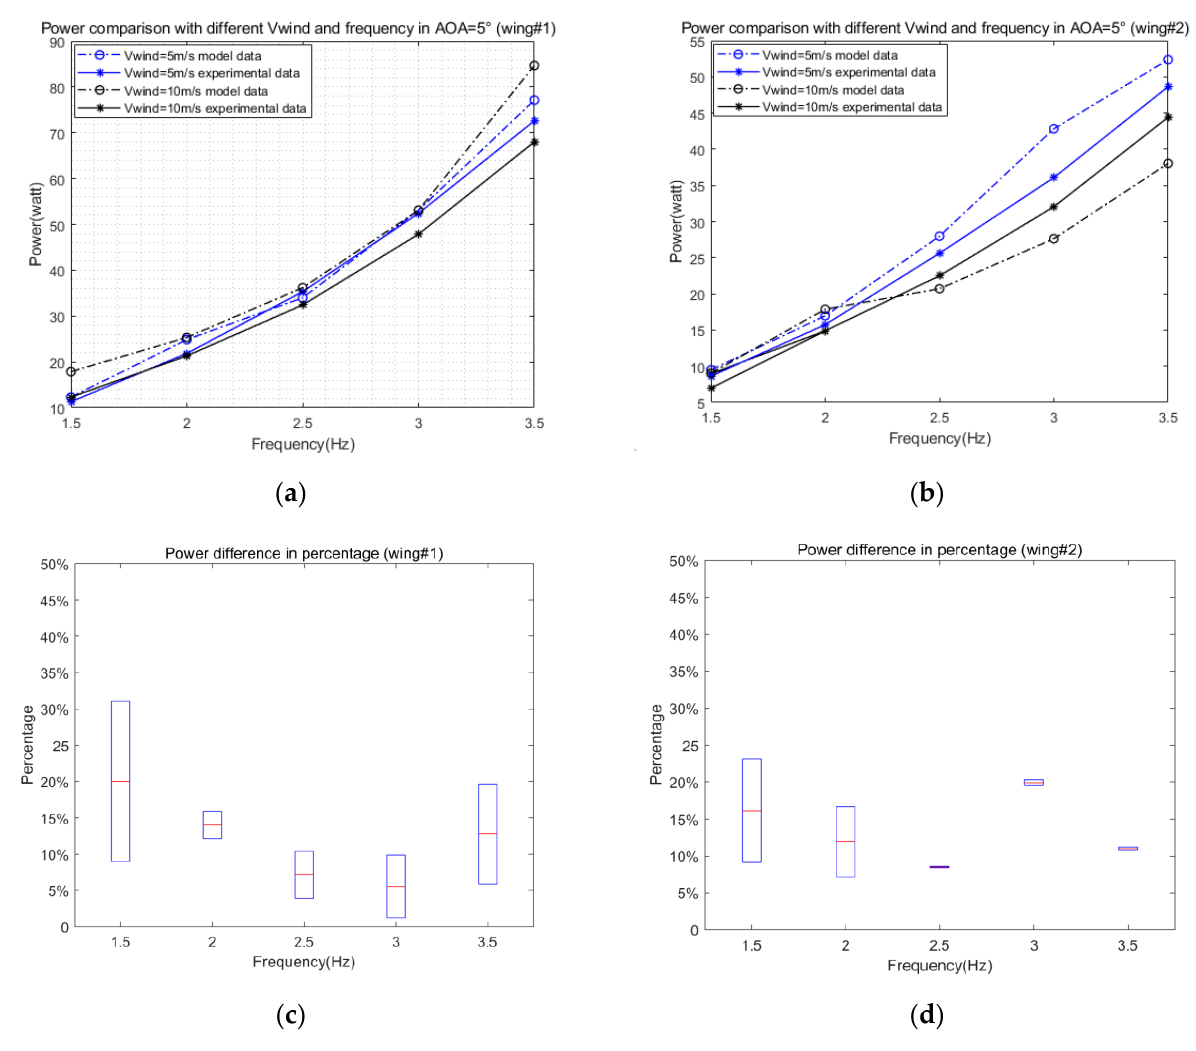
Figure 10. ( a ) Power comparison of wing #1 with different velocity of wind and frequency in AOA = 5 m/s; ( b ) power comparison of wing #2 with different velocity of wind and frequency in AOA = 5 m/s; ( c ) power difference in percentage between the experimental and model result of wing #1; ( d ) power difference in percentage between the experimental and model result of wing